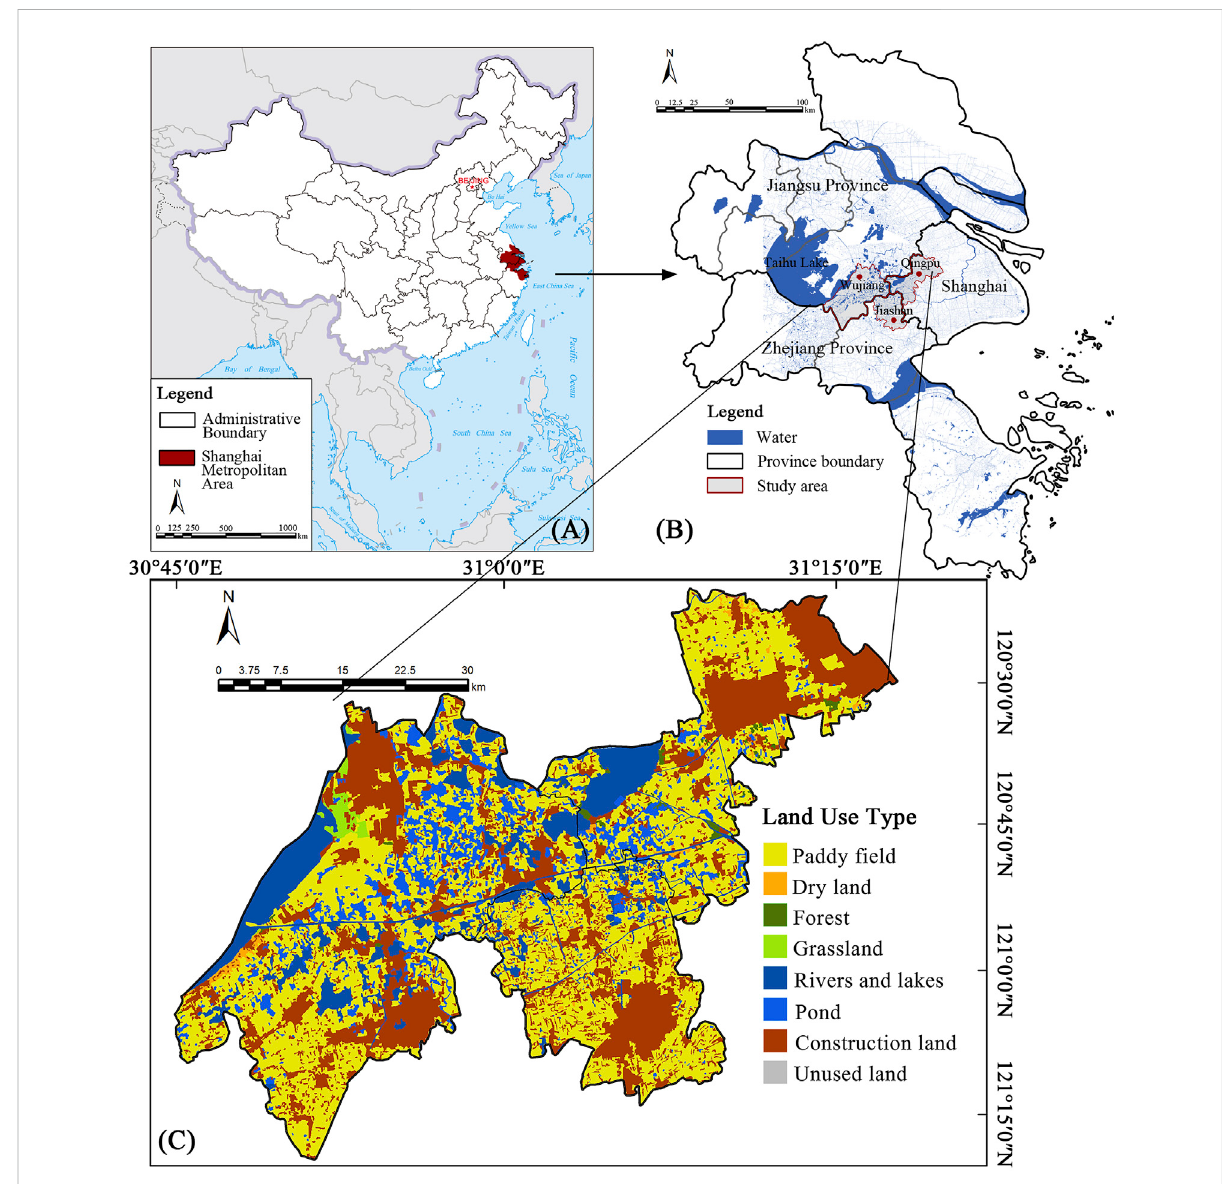
FIGURE 1 Geographicallocation ofthestudy area. (A) Geographicallocation ofShanghaimetropolitanarea. (B) Location mapof thestudy area. (C) Land- use type of the study